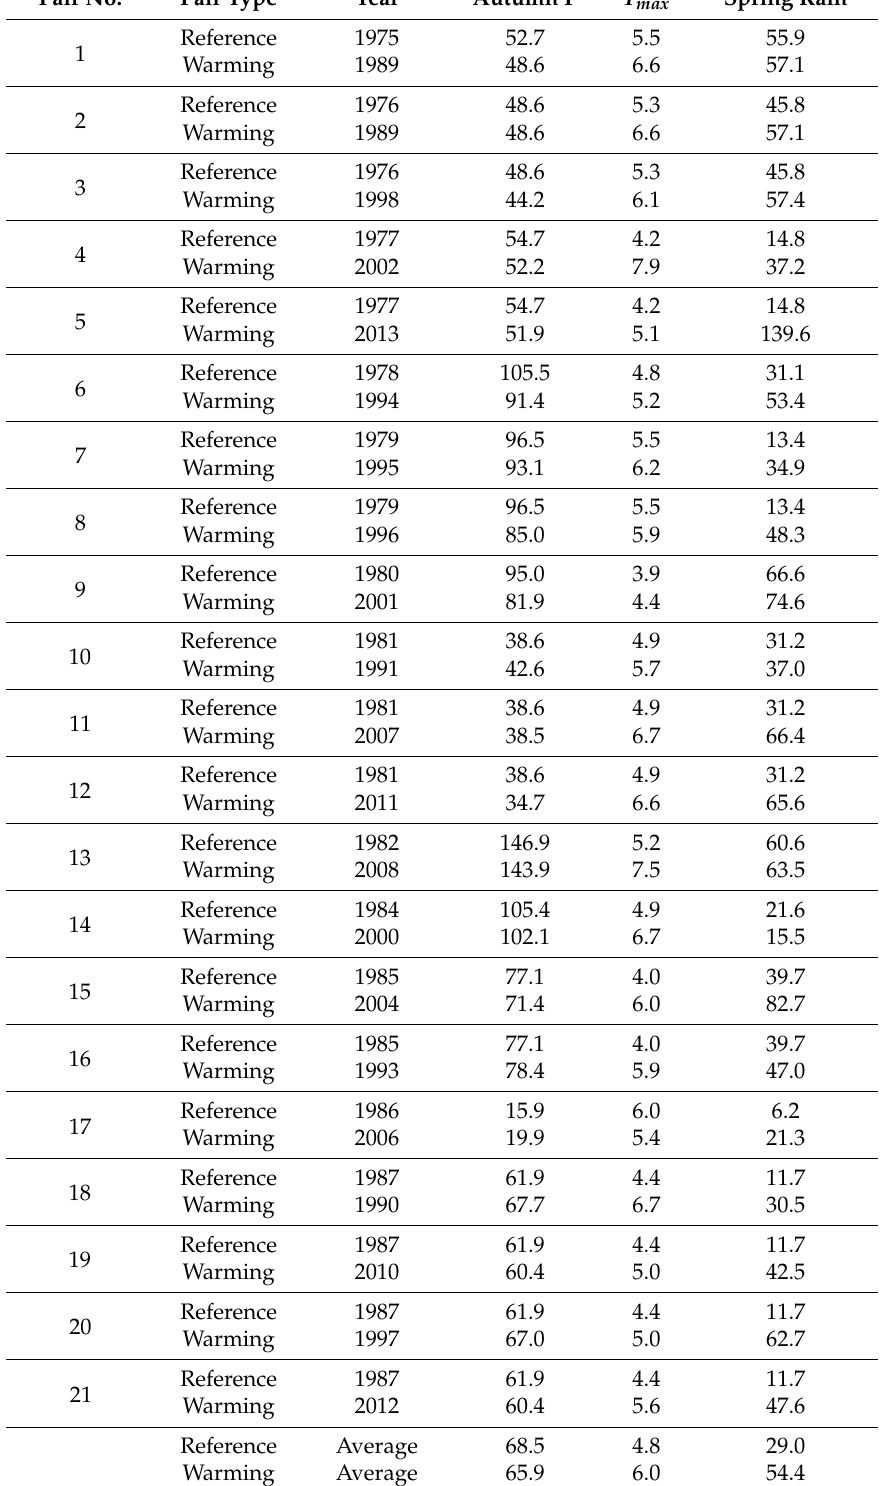
Table A5. Selected pairs for quantifying the effect of climate warming on high flow timing in the UHR watershed. Pair